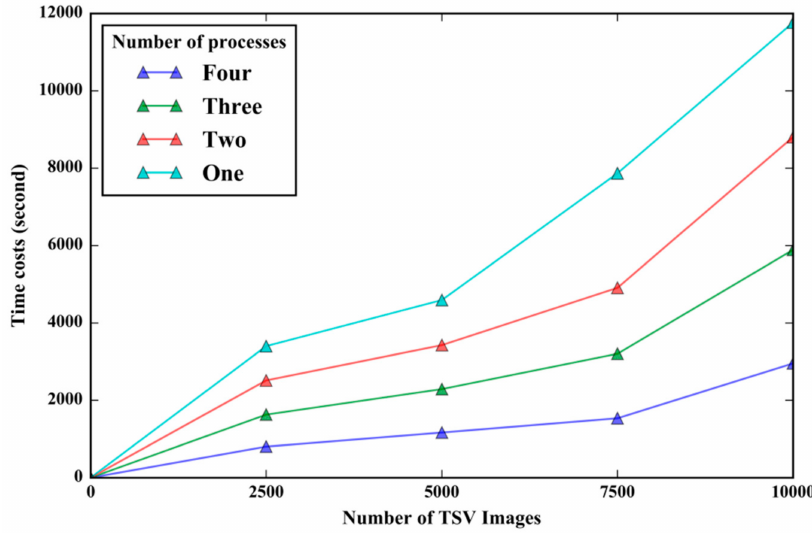
Figure A1. Comparison of the time costs of crawlers with different